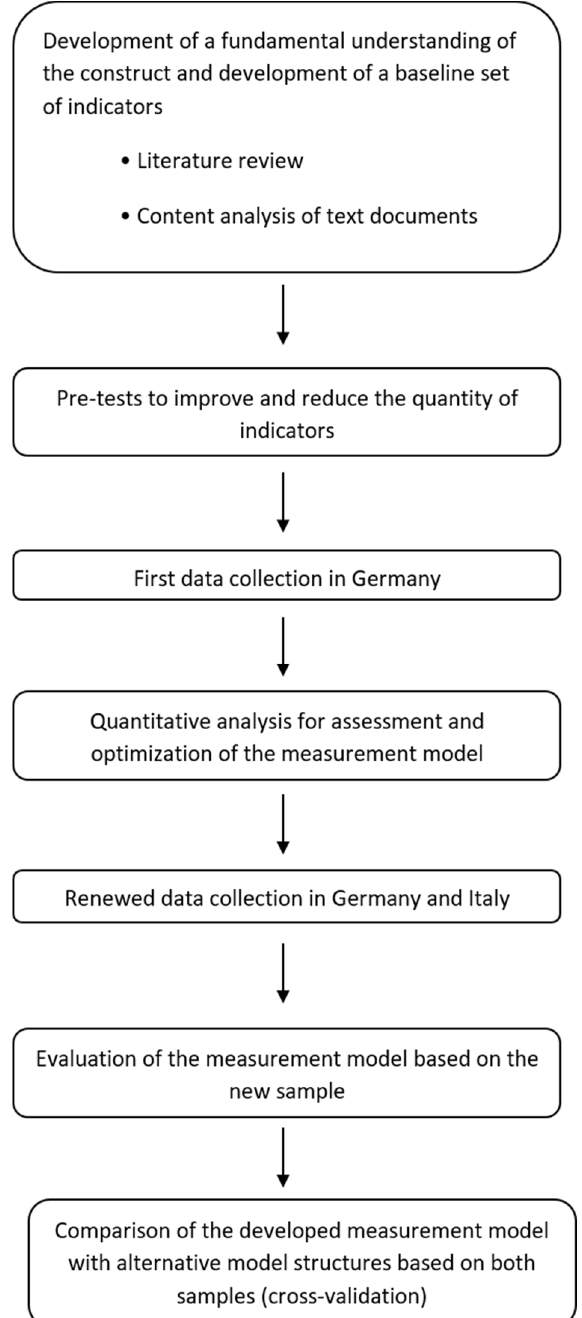
Figure 2. The research